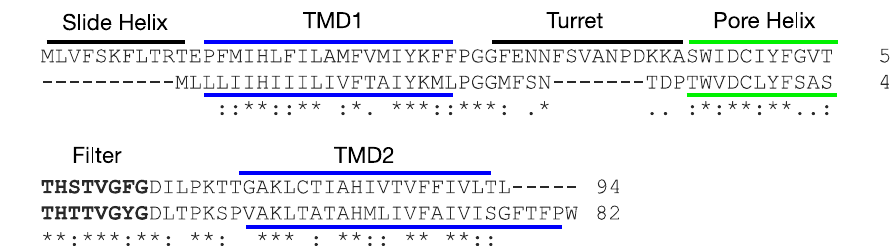
Figure 1. Kcv ATCV-1 sequence alignment with the sequence of the prototype chlorovirus K + channel Kcv PBCV-1 by ClustalW. The slide helix, outer transmembrane (TMD1) turret, pore helix, selectivity filter, and inner transmembrane (TMD2) of the Kcv PBCV-1 are highlighted by the horizontal lines. Asterisks indicate positions which have a fully conserved residue. A colon indicates conservation between amino acids with strongly similar properties. A period indicates conservation between amino acids with less similar properties.